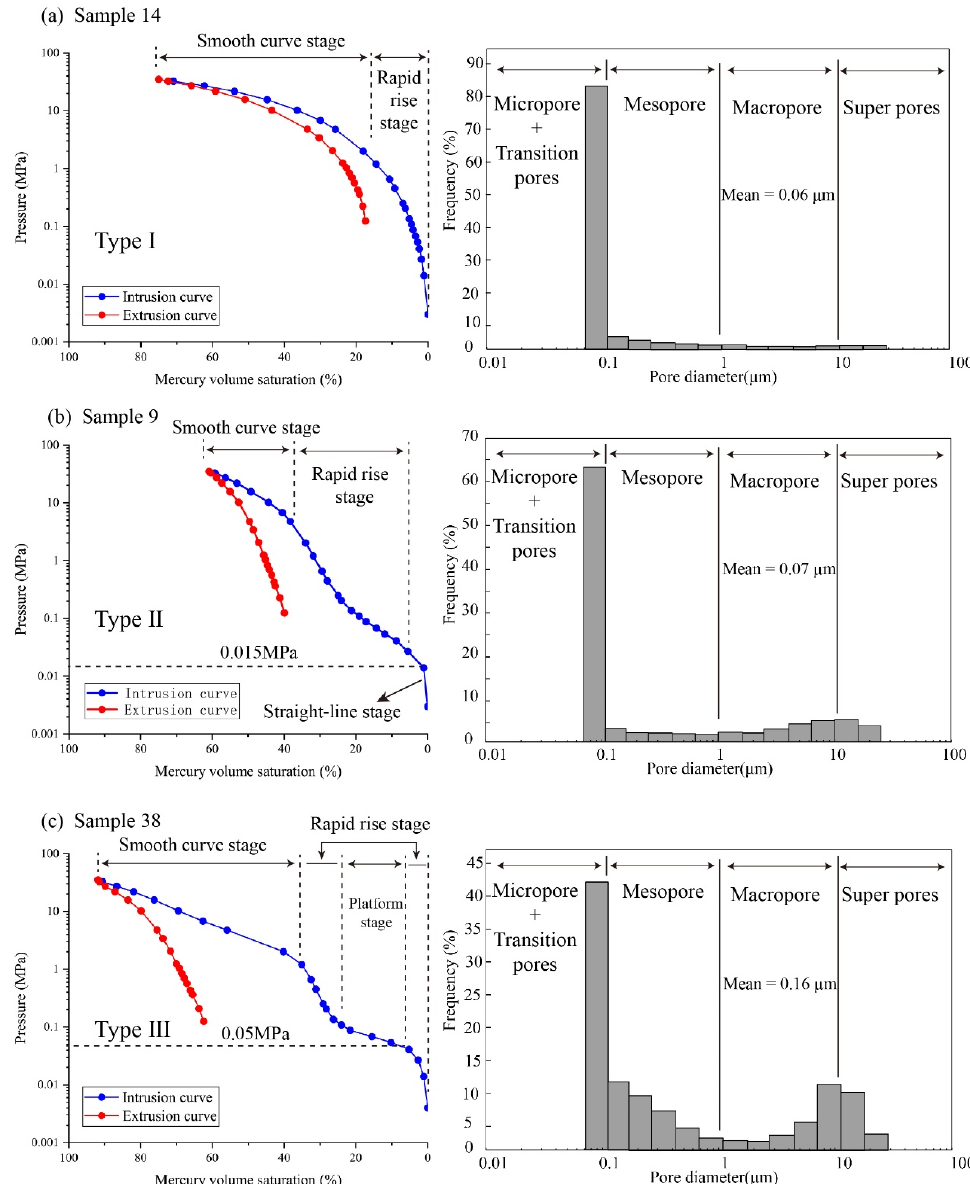
Figure 5. The pore size and volume distribution of 15 coal samples from Sangjiang-Muling coal-bearing